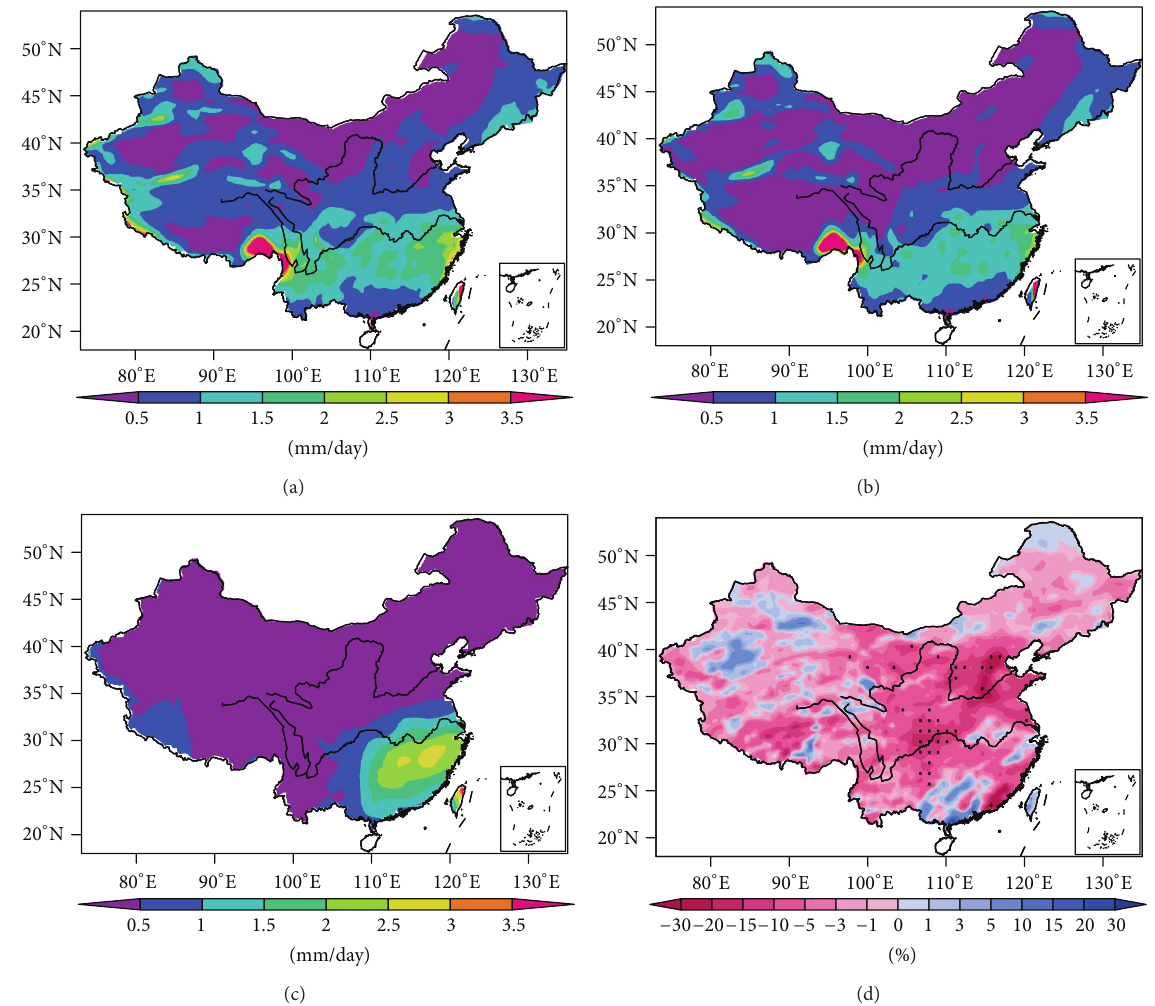
Figure 10: Precipitation rate for (a) Nodust, (b) Dust, (c) CRU, and (d) percentage change between Dust and Nodust experiments averaged in winter during 2000–2009 period; the black dots in (d) indicate areas in which the difference is statistically significant at the 95% confidence level (Student’s t